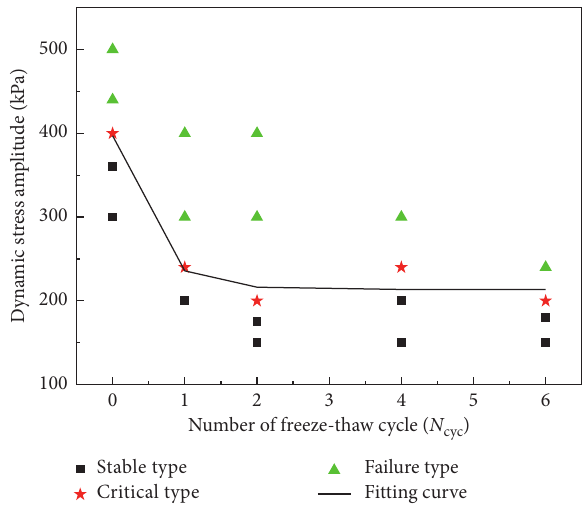
Figure 7: Relationship between the number of freeze-thaw cycles and threshold dynamic stress. Table 3: Fitting parameters of the empirical model of dynamic permanent deformation of embankment soil under long-term train load. N